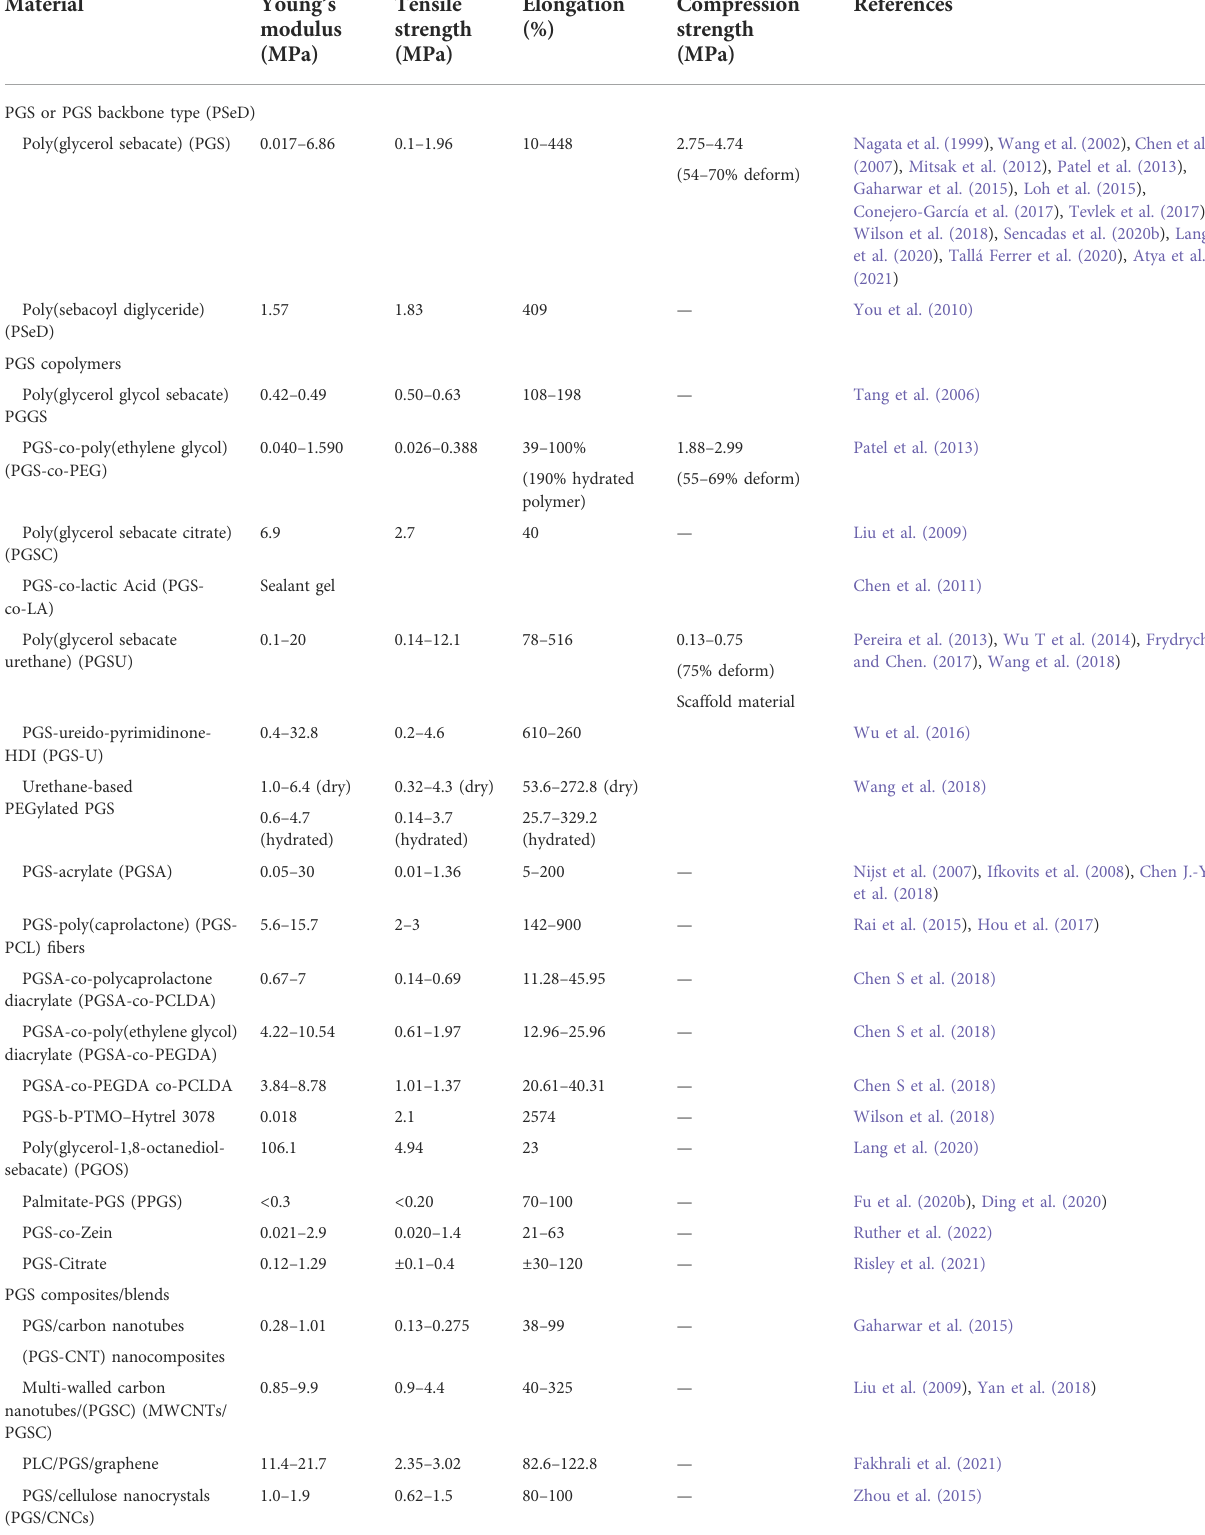
TABLE 2 Mechanical properties of PGS and PGS-based